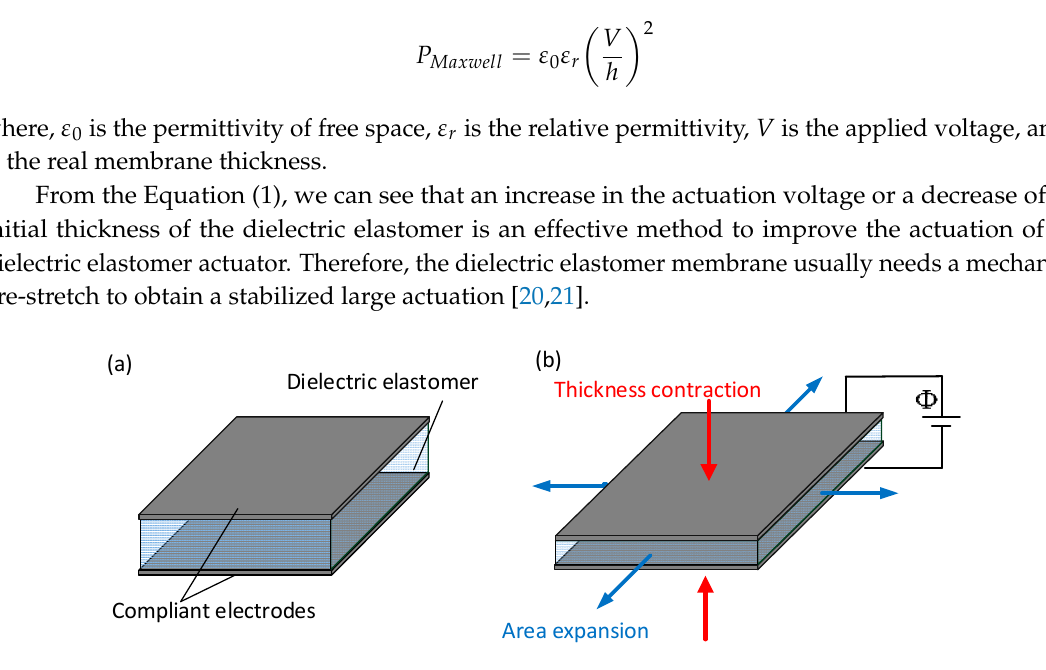
Figure 1. Schematic of an actuated dielectric elastomer ( a ) Reference state; ( b ) Actuation state.